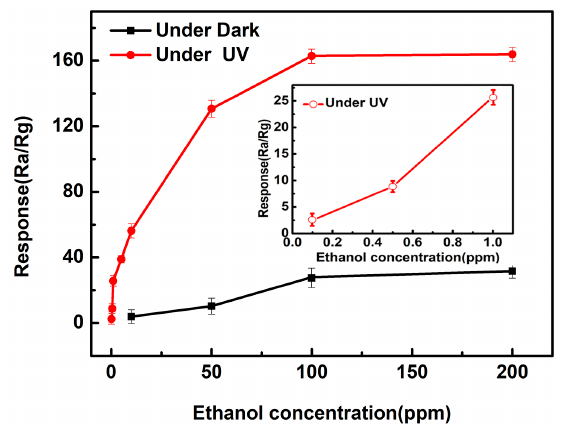
Figure 5. Response of the ZnO film sensor to different concentrations of C 2 H 5 OH from 0.1 to 200 ppm under dark and under UV LED activation.